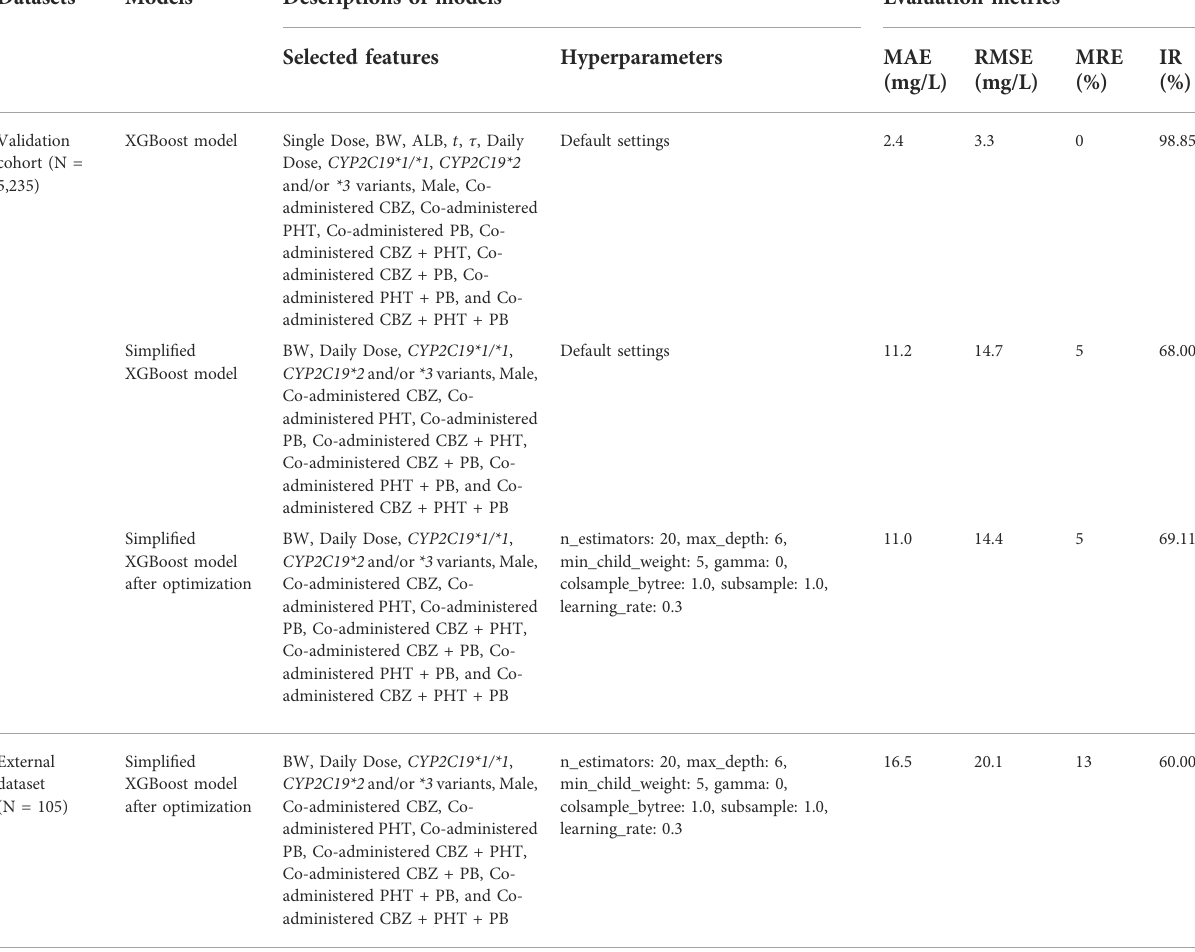
TABLE 6 Comparisons of the performance of the proposed models on the validation cohort and the independent external dataset. Datasets